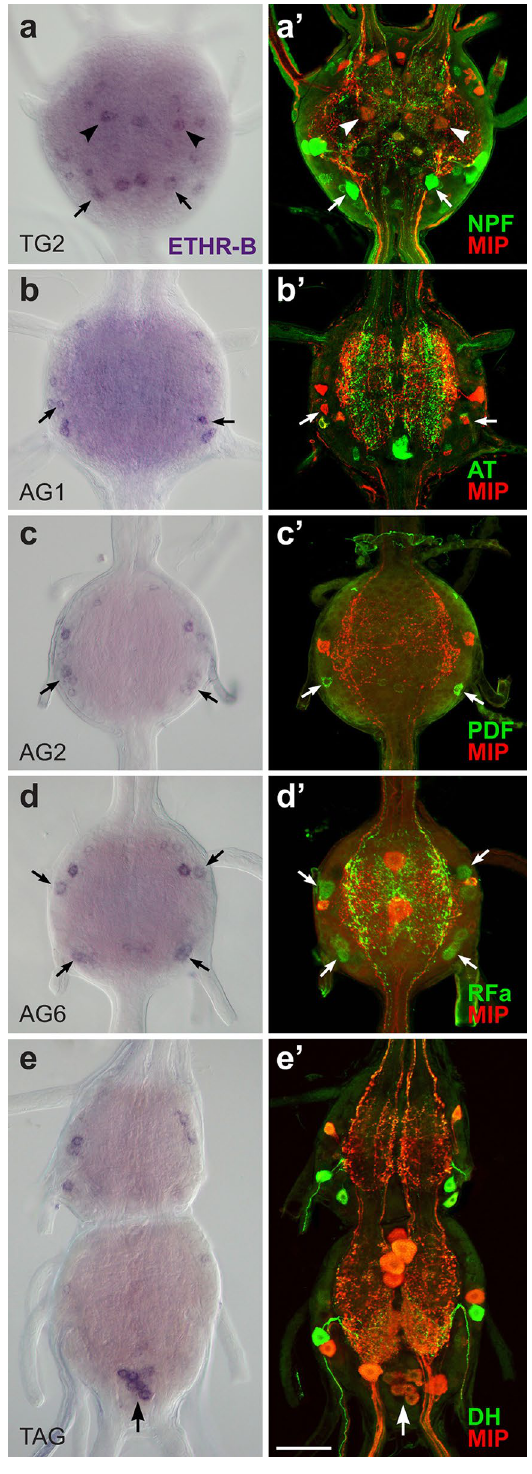
Figure 8. Identification of ETHR-B neurons in the CNS of pharate larvae. ( a – e ʼ ) ISH with ETHR-B probe and following staining of the same ganglia with various antibodies. ( a , a ’) Coexpression of ETHR-B with MIP (arrowheads; red) and NPF (arrows; green) in the TG2. ( b , b ’) Colocalization of ETHR-B transcript and MIP (arrows; red) in a pair of small neurons of the AG1. ( c , c ’) A posterolateral pair of ETHR-B neurons stained with PDF antibody in the AG2 (arrows; green). ( d , d ’) Coexpression of ETHR-B and RFamide-like peptide (arrows; green) in 2–3 pairs of lateral neurons in the AG6. ( e , e ’) A cluster of PM9 neurons expressing ETHR-B in the posterior TAG identified with MIP antibody (arrow; red). Note that other ETHR-B neurons failed to react with antibodies to MIP (red; a ’– e ’), AT (green; b ’) or DH (green; e´). Scale bar = 50